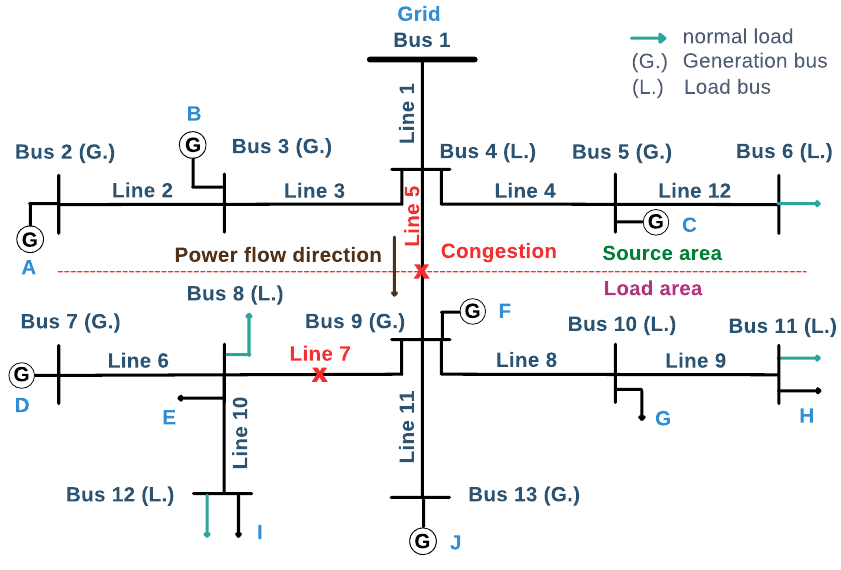
Figure 8 . The partitioning zones for Case 2 . Figure 8. The partitioning zones for Case 2.